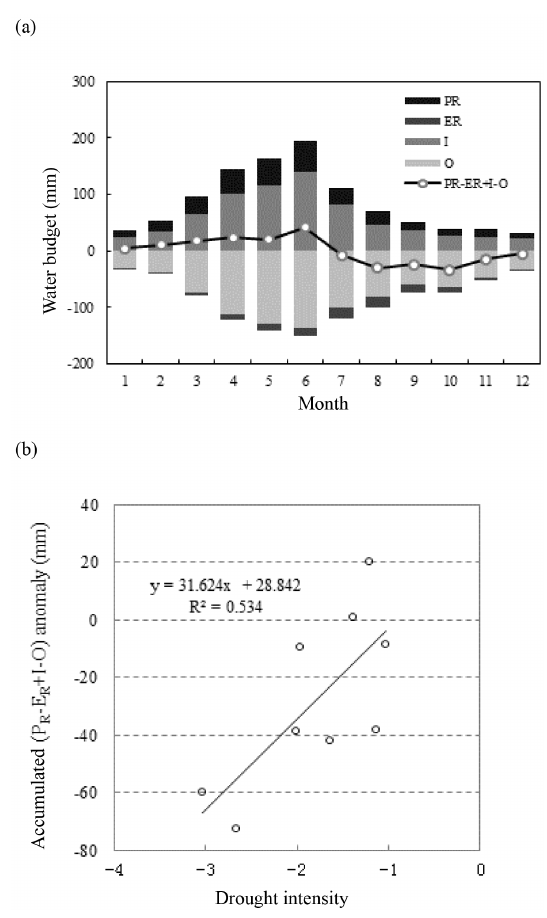
Figure 4. (a) Multi-year mean of monthly precipitation ( P R ) and evapotranspiration ( E R ) for the Poyang Lake region, lake inflow ( I ) from five major rivers of the Poyang Lake basin, and outflow ( O ) into the Yangtze River. All the water amounts are normalized to equivalent water height of the whole Poyang Lake basin. (b) The relationship between drought intensity and accumulated anomaly of ( P R − E R + I ) of each event for nine cases of Poyang Lake droughts.